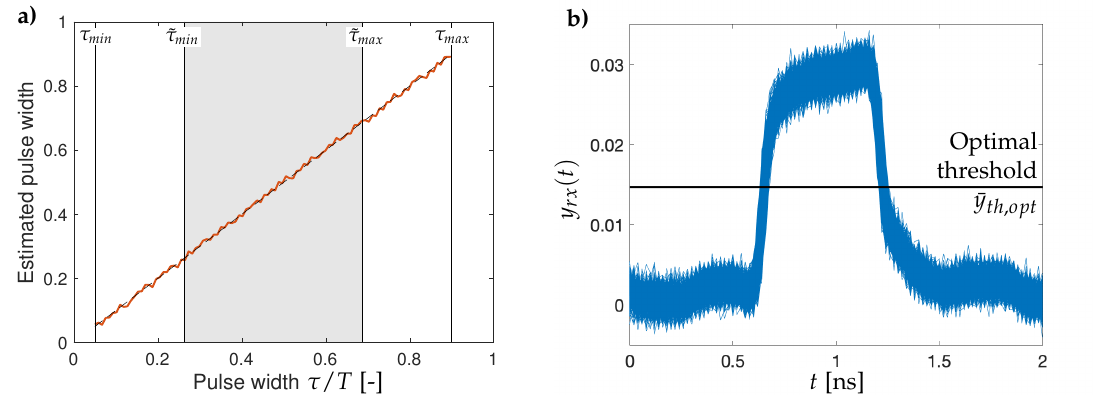
Figure 4. ( a ) calibration curve with highlighted duration domains: full ( τ min , τ max ) and halved (˜ τ min , ˜ τ max ) dynamics; ( b ) superimposition of the received instances obtained during the calibration stage for the pulse of duration τ = 0.27 T . ·